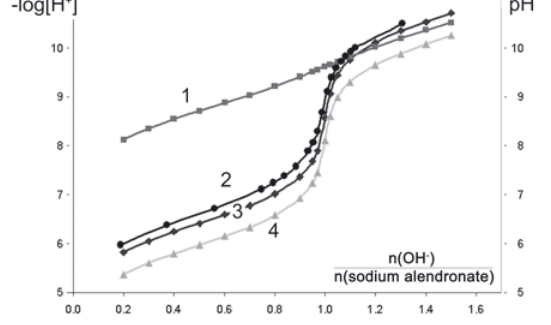
Figure 2. Calculated and experimental titration curves of 0.02 M sodium alendronate with 0.04 M alkali solution.